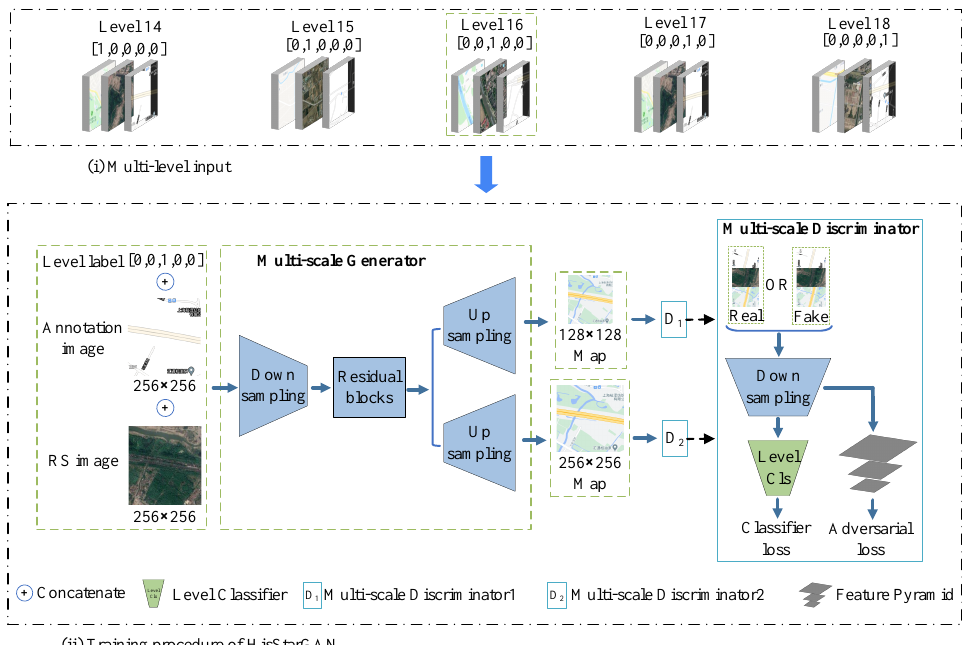
Figure 4. The architecture of the proposed CscGAN.